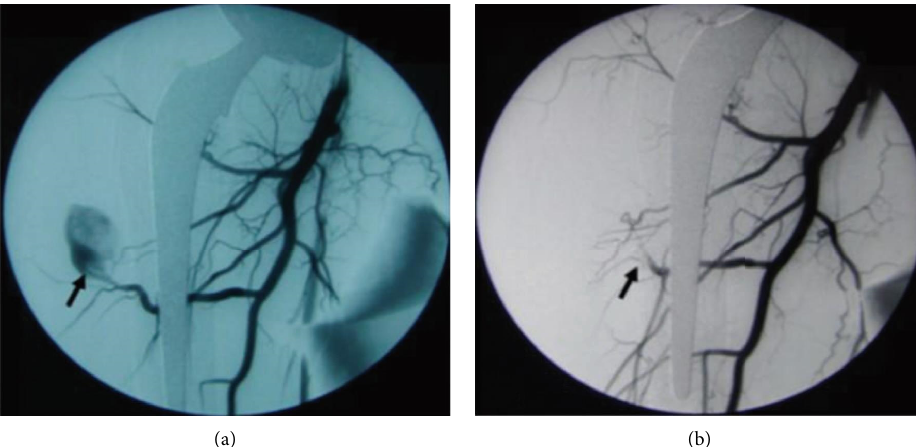
Figure 2: (a) Arteriography showing the pseudoaneurysm pre-embolization. (b) Arteriography showing resolution of the pseudoaneurysm postembolization.